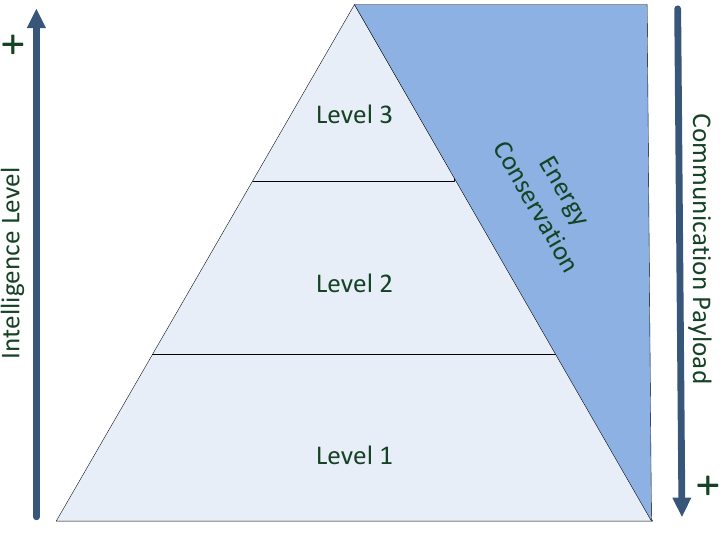
Figure 3. Location of intelligence versus communication